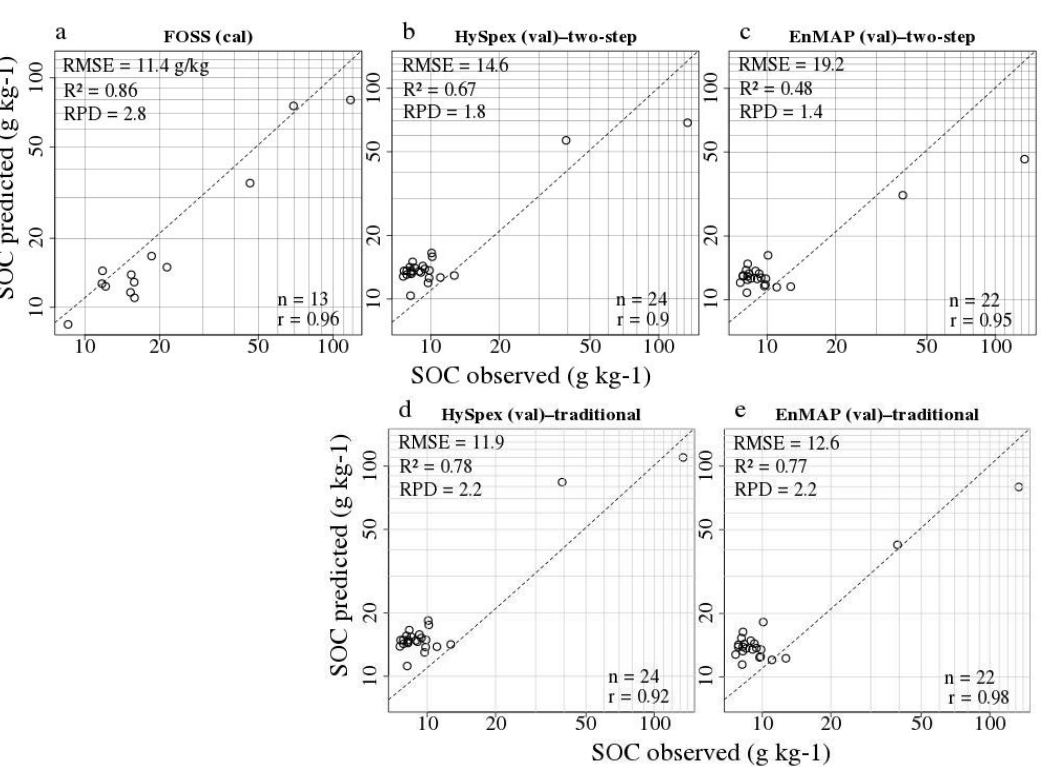
Figure 7. PLSR coefficients for the airborne HySpex model ( a ) and simulated satellite EnMAP model ( b ) using the two-step approach. Dotted lines represent one standard deviation of the coefficients.